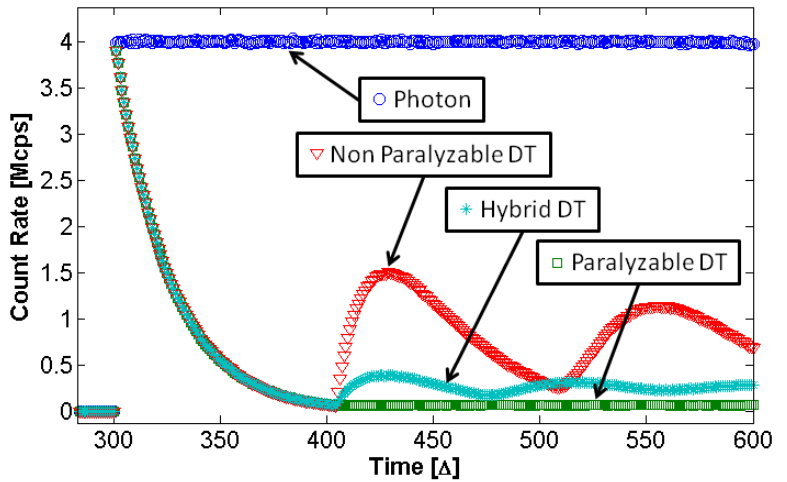
Figure 2. Histograms of rate vs . time; blue circle, simulated photon source rate; dark green square, P-DT model simulation; red triangle, NP-DT model simulation; cyan asterisk, hybrid DT model